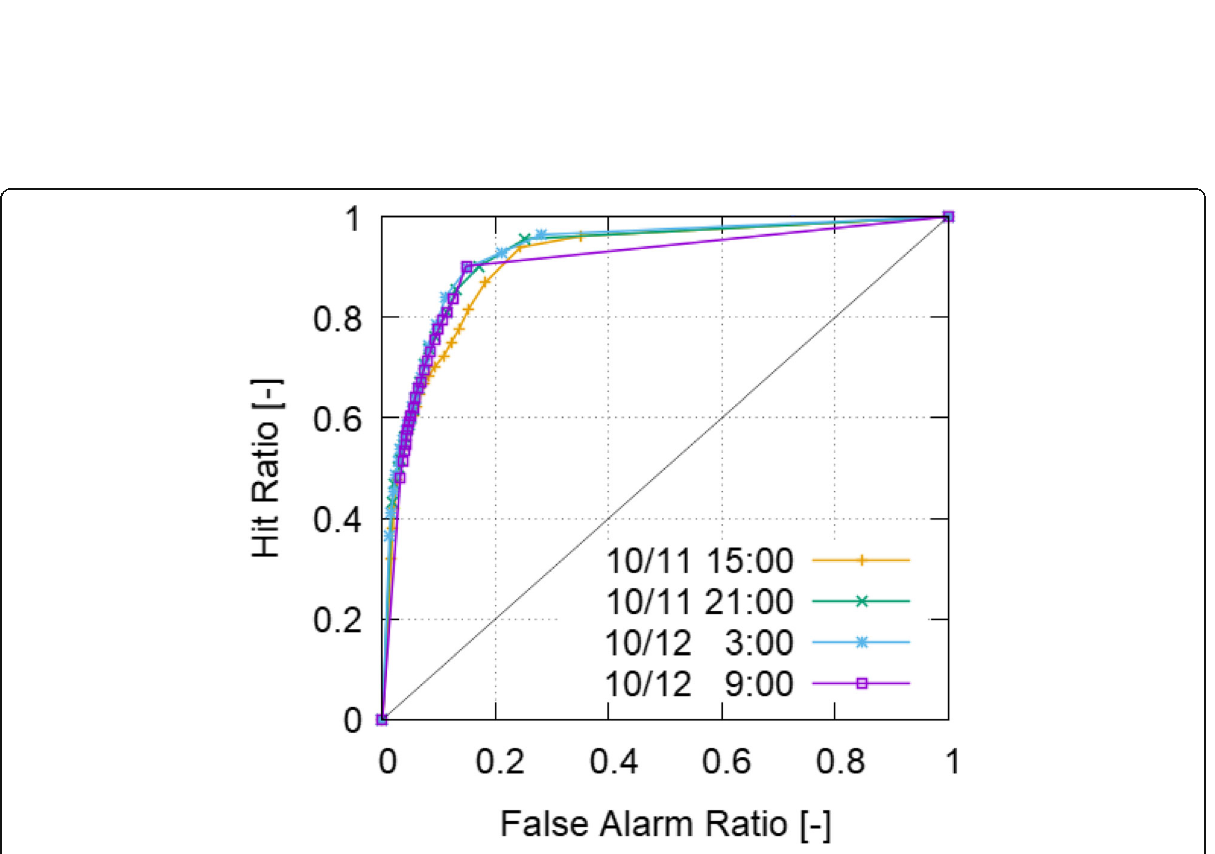
Fig. 13 The effects of different initial times on the forecasted hydrograph evaluated by the ROC curve in Kanto Region for